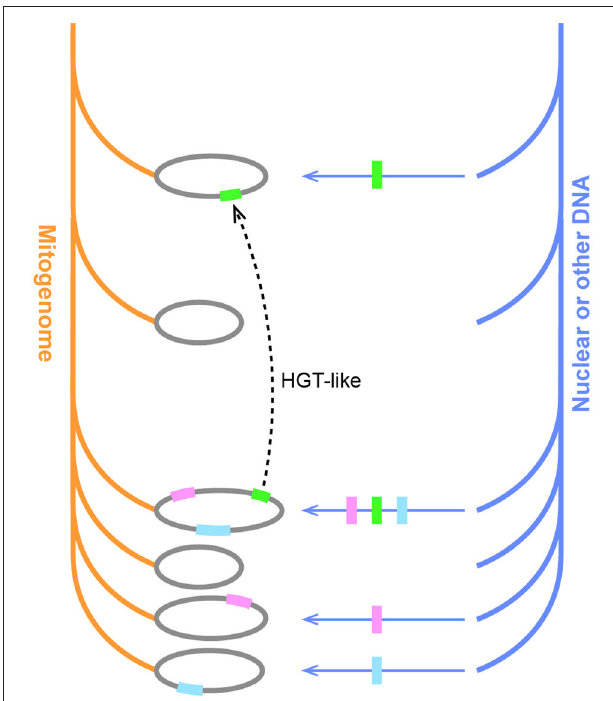
FIGURE 7 | The hypothesis of the mosaic evolution in plant mitogenomes. Orange and blue branches represent the inheritance of mitogenome and other DNA, respectively. Horizontal arrows indicate DNA transfers, and colorful blocks indicate different sequences. Unequal transfers result in some species acquiring additional homologs. The dotted line indicates the creation of an HGT-like sequence upon the transfer of a single sequence on two independent occasions in distant